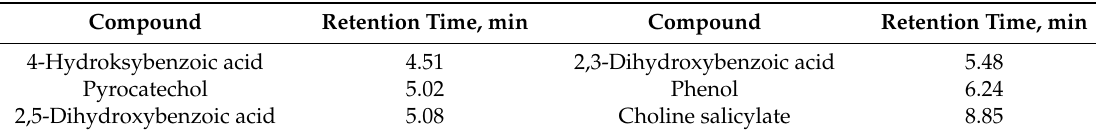
Table 1. Comparison of retention times of standard solutions of potential impurities and degradation products observed under conditions of CS purity analysis by HPLC-UV.